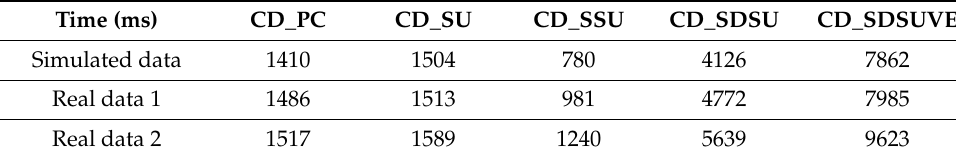
Table 8. Time costs of all the methods in the three experiments.